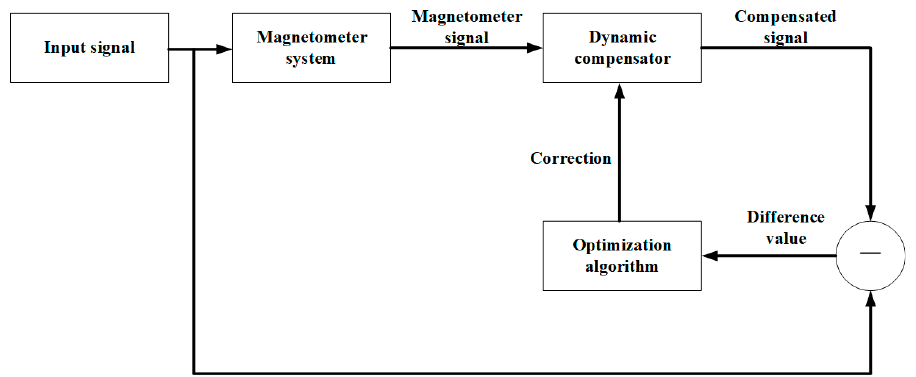
Figure 7. The basic principle of the dynamic compensation solution.